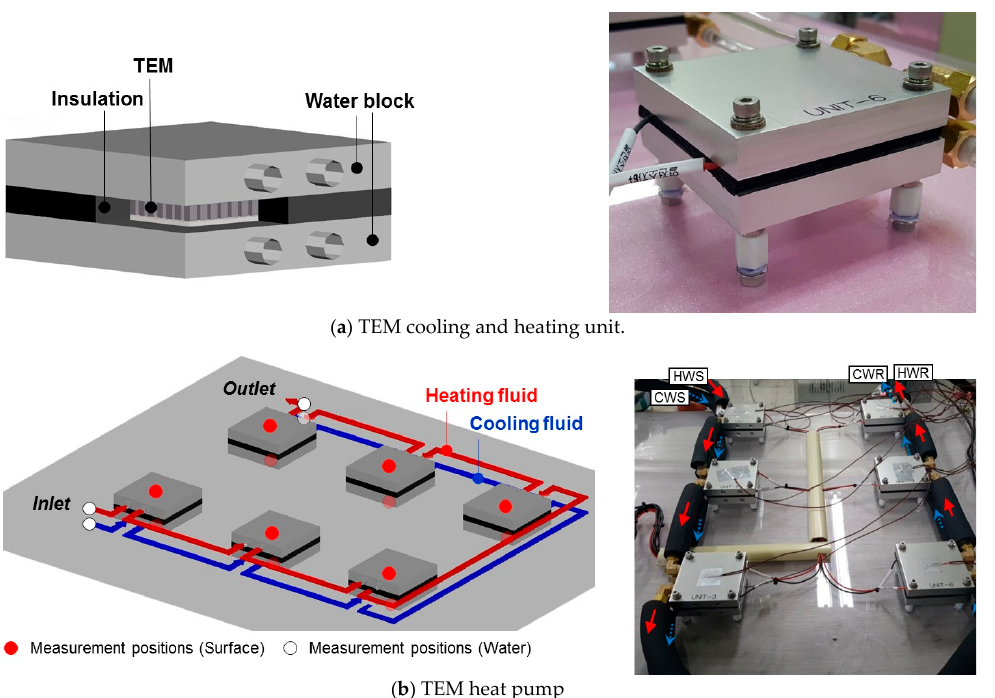
Figure 1. Thermoelectric heat pump test setup.